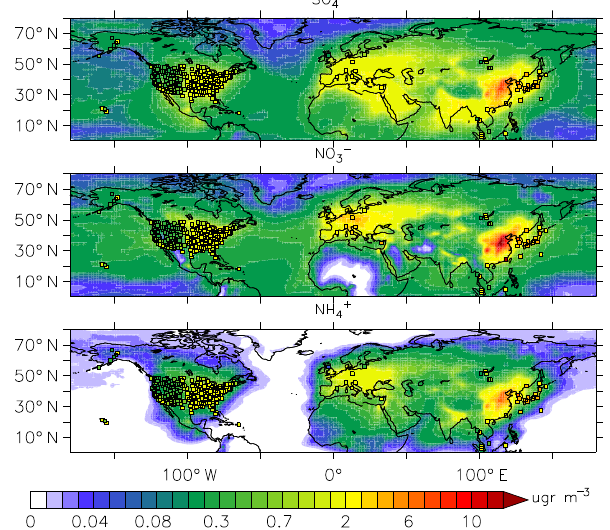
2 . 5 components (SO 2 − , NO − and NH + ) in µgm − 3 at the surface for the year 2010, 4 3 4 with observations from EPA, EMEP and EANET (averaged over the same period)